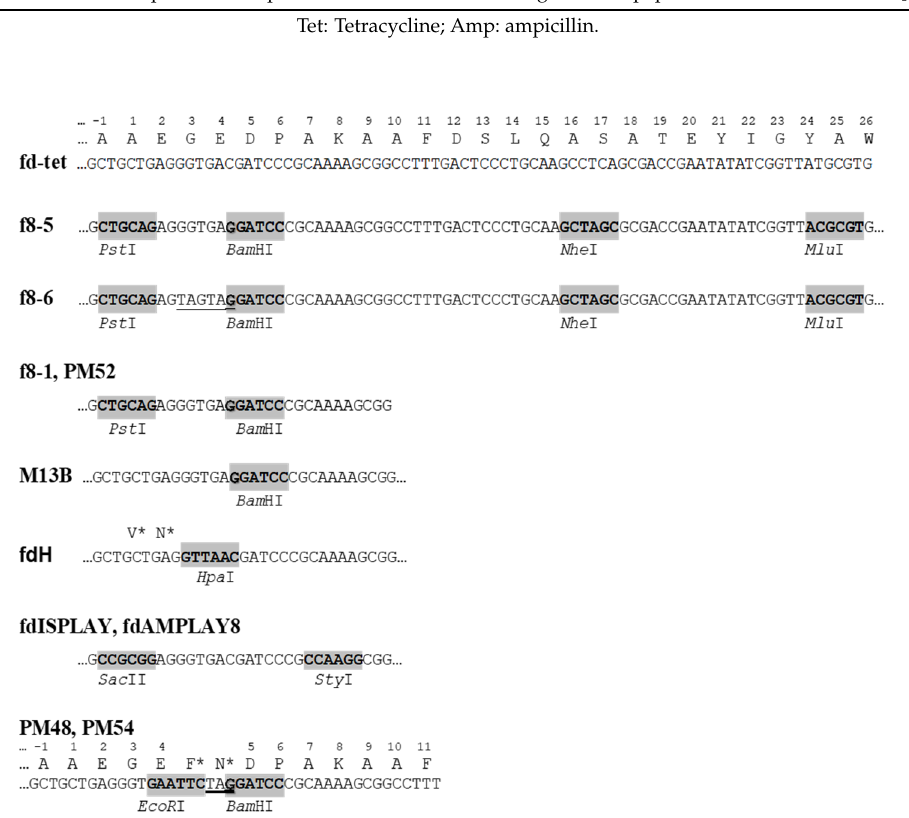
Figure 4. Cloning sites in p8-type filamentous phage vectors. Stop codons are underlined; asterisks mark amino acids synthesized in repressor strains.